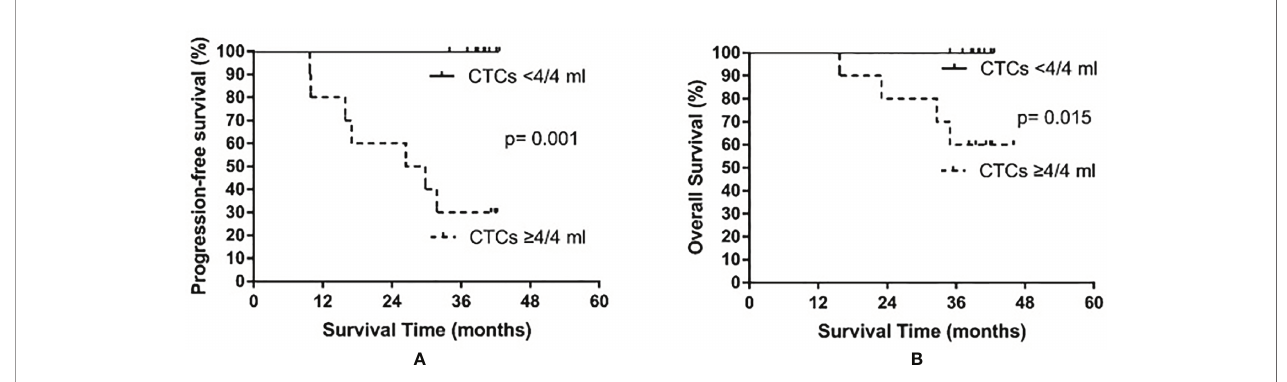
FIGURE 4 | Progression-free survival (A) and overall survival (B) in small cell lung cancer patients according to circulating tumor cell (CTC) count after prophylactic